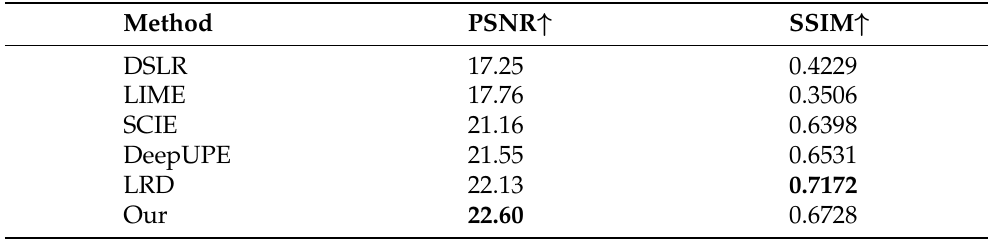
Table 2. Quantitative evaluation on SID dataset, in terms of PSNR and SSIM. The best results are in bold.